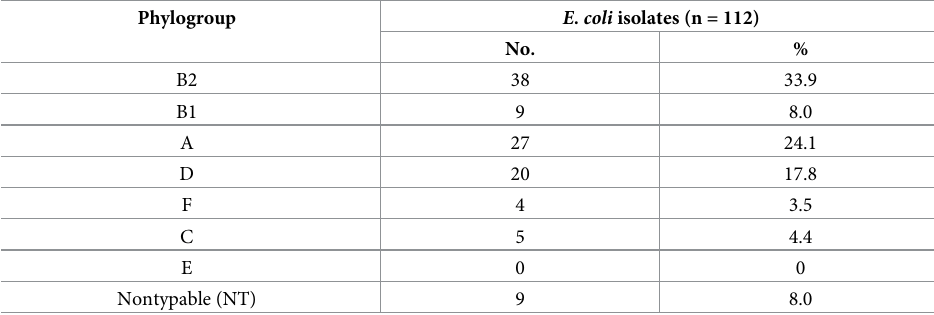
Table 5. Distribution of E . coli phylogroups among 112 UPEC isolates from outpatients with acute